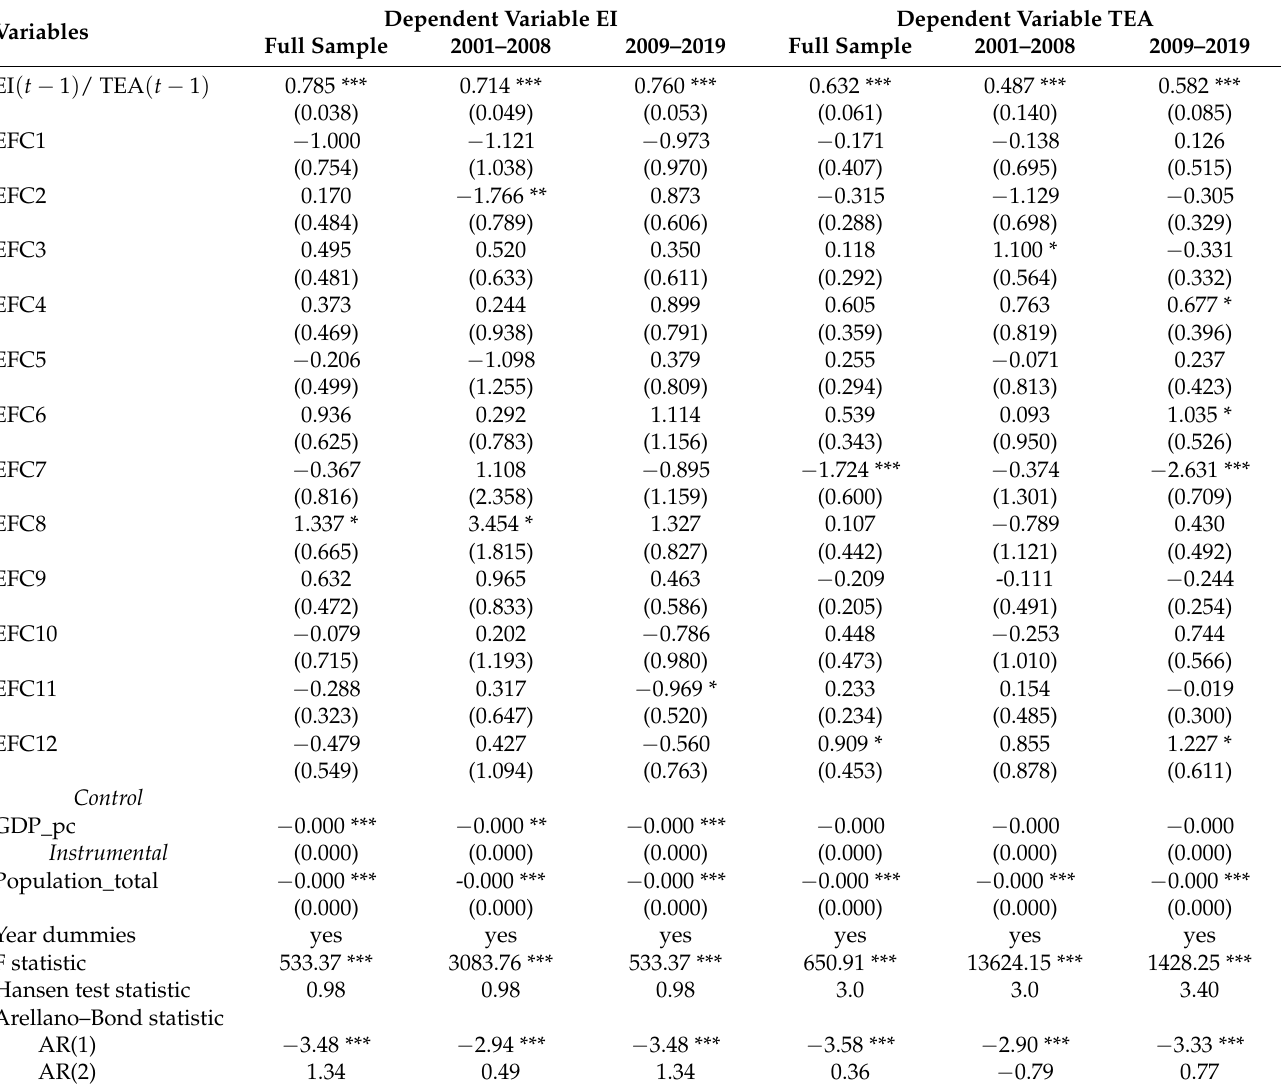
Table 6. Results from system GMM